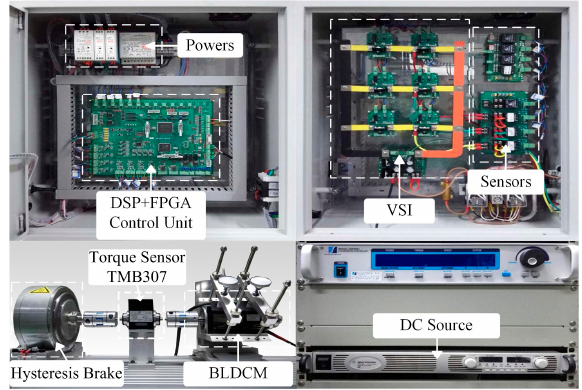
Figure 7. Experimental system.